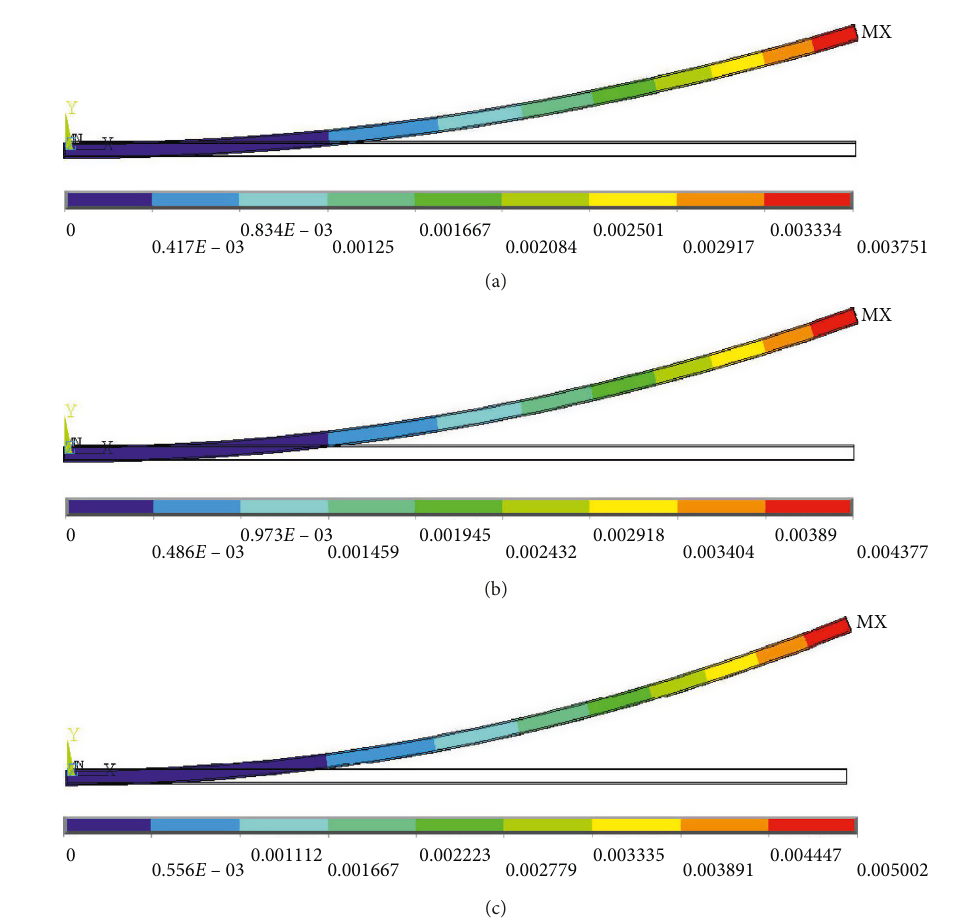
Figure 14: (a–c) Displacement calculation results for the input voltages of 3 V, 3.5V, and 4V,